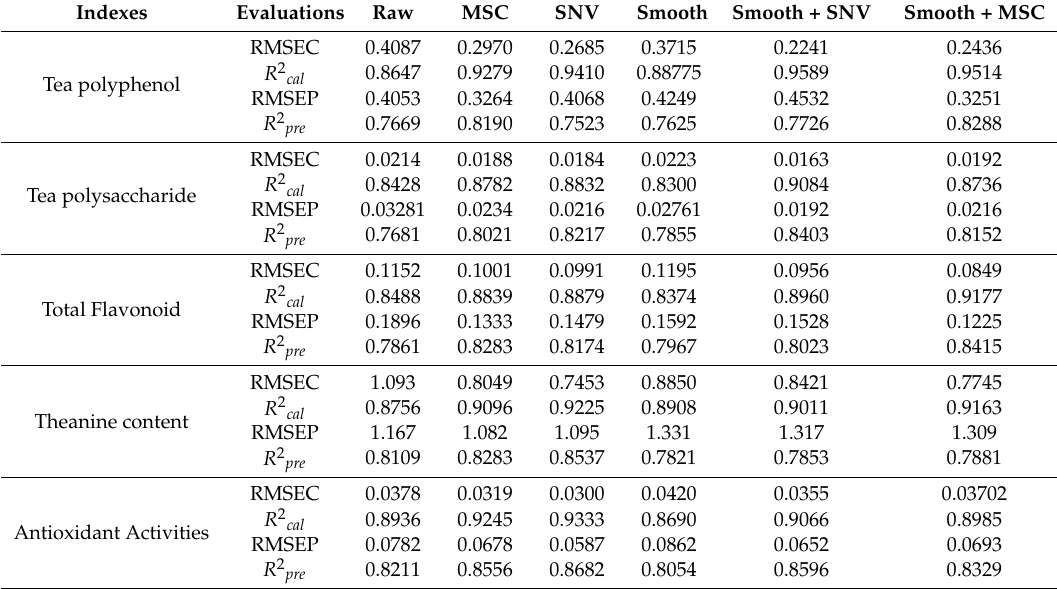
Table 3. Results for calibration model with different spectrum pre-processing based on Weighted PLS